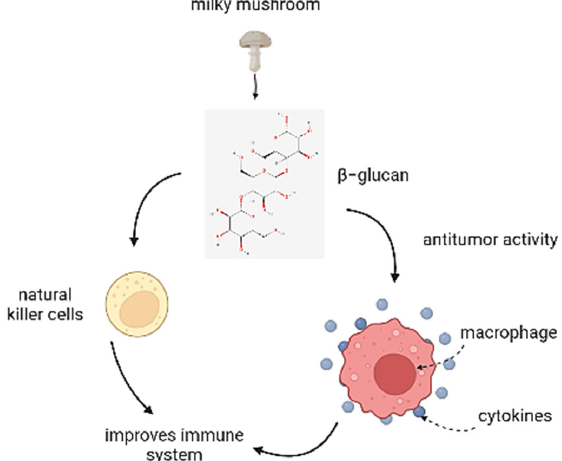
Figure 5. Anti-inflammatory mechanism of Calocybe indica.